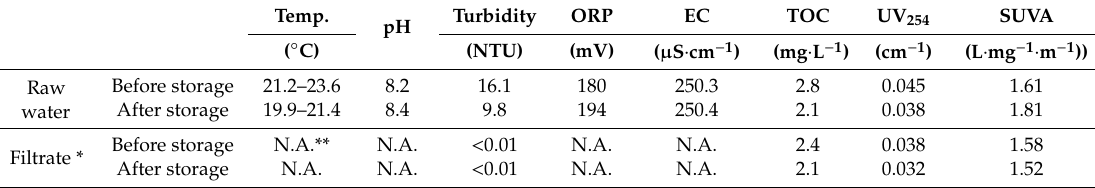
Table 1. Raw water and filtrate * quality (November 2014).